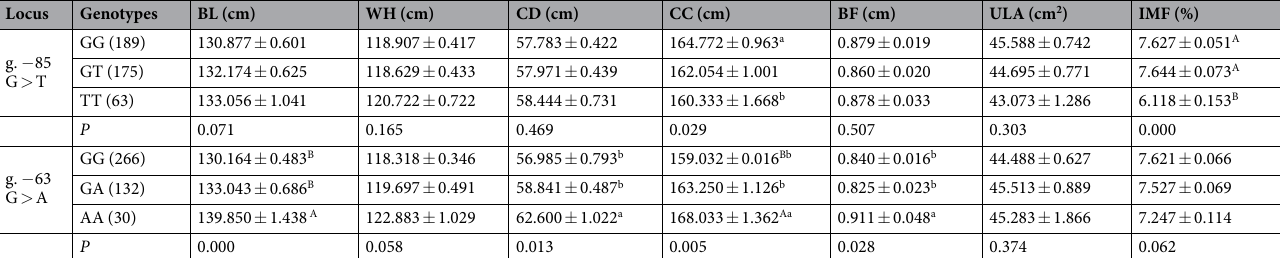
Table 2. Association of different genotypes of SNPs in SIX1 with body measurements in Qinchuan cattle. Values are shown as the means ± standard error. Values with different superscripts in the same column differ significantly at P < 0.05 (a,b) and P < 0.01 (A,B) after Bonferroni correction. Body length (BL),withers height (WH), chest depth (CD), chest circumference (CC), back fat thickness (BF), ultrasound loin muscle area (ULA) and intramuscular fat content (IFC).